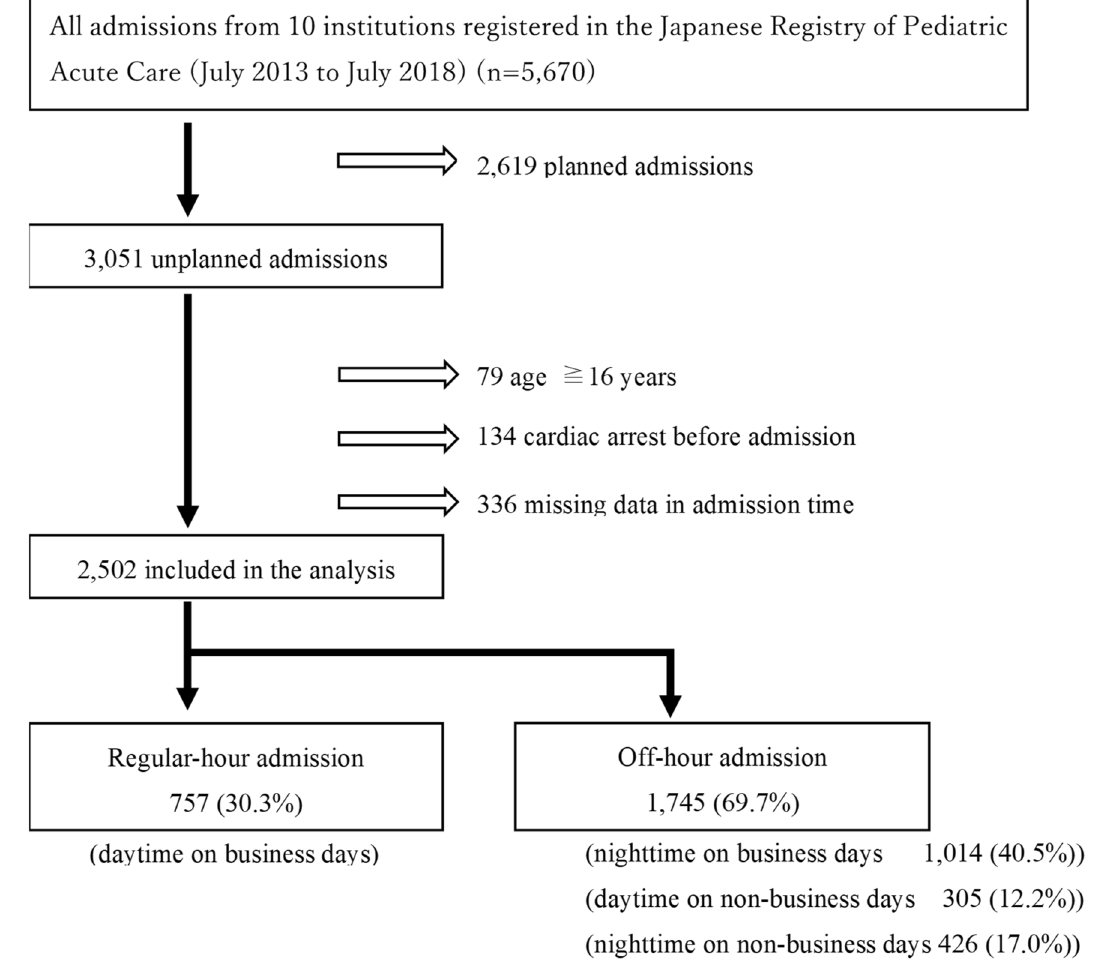
Figure 1. Flowchart of patient selection. Study subjects were selected from the data registered in the JaRPAC registry during the study period, according to the inclusion and exclusion criteria. Study subjects were grouped into regular-hours admissions (n = 757) and off-hours admissions (n = 1754). JaRPAC = Japanese Registry of Pediatric Acute